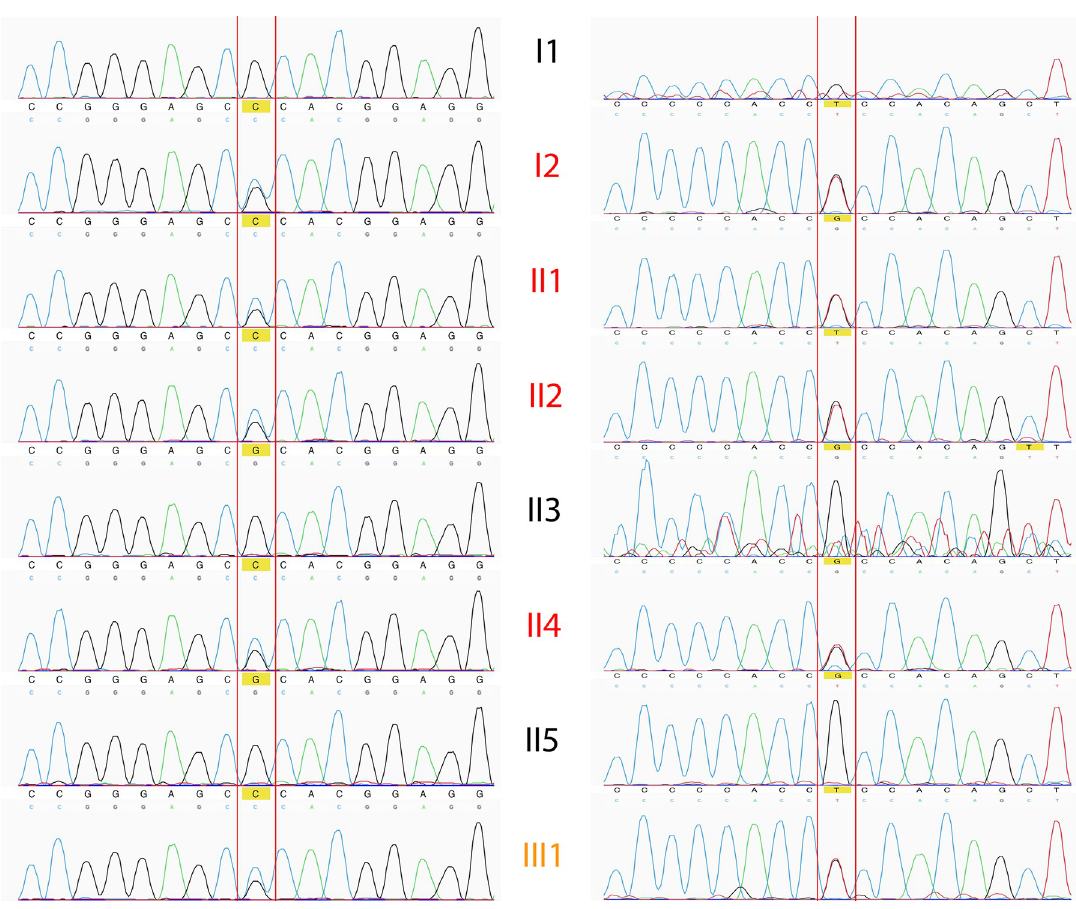
Fig 4. Sanger validation of candidate GUCY2D causative variants. Both GUCY2D identified variants (c.2513G > C on the left, and c.3044-7G > T on the right) were validated by Sanger sequencing in all family members. Black text = Healthy family member; Red text = Affected family member. Orange text = Uncertain phenotype in this family member.